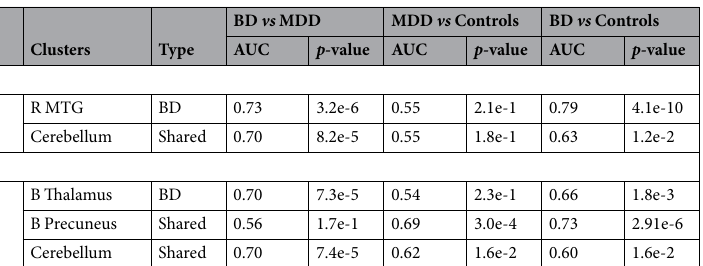
Table 3. The classification results for the brain clusters showing a significant group effect in the FCS ( p < 0.001 Alphasim corrected, ANCOVA). The ‘BD’ type indicates that the FCS in the cluster was altered specifically in the BD patients but not in the MDD patients. The ‘shared’ type indicates that the cluster with altered FCS was detected in both the BD and the MDD patients. Abbreviations: lFCS (sFCS), long-range (short-range) functional connectivity strength; BD (MDD), bipolar (major depressive) disorder; MTG, middle temporal gyrus; AUC: area under the ROC curve; B (R), bilateral